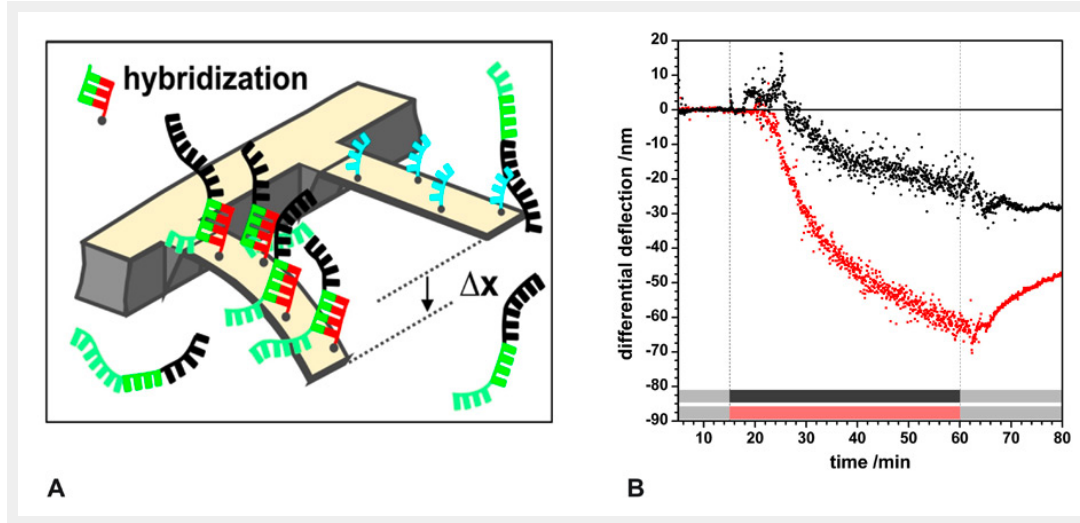
(A) The example of DNA hybridisation to immobilised oligonucleotides illustrates the molecular crowding, which creates a surface stress resulting in cantilever bending. A differential deflection (Δx) can be measured with the help of a reference cantilever. (B) Measurement of total RNA from a BRAF mutated melanoma cell line (red) and from a cell line (black) that does not contain the BRAF mutation. Injection is indicated with a red and black bar at the bottom of the graph. The measurement device is washed with buffer before and after injection. The two cell lines can be clearly distinguished.